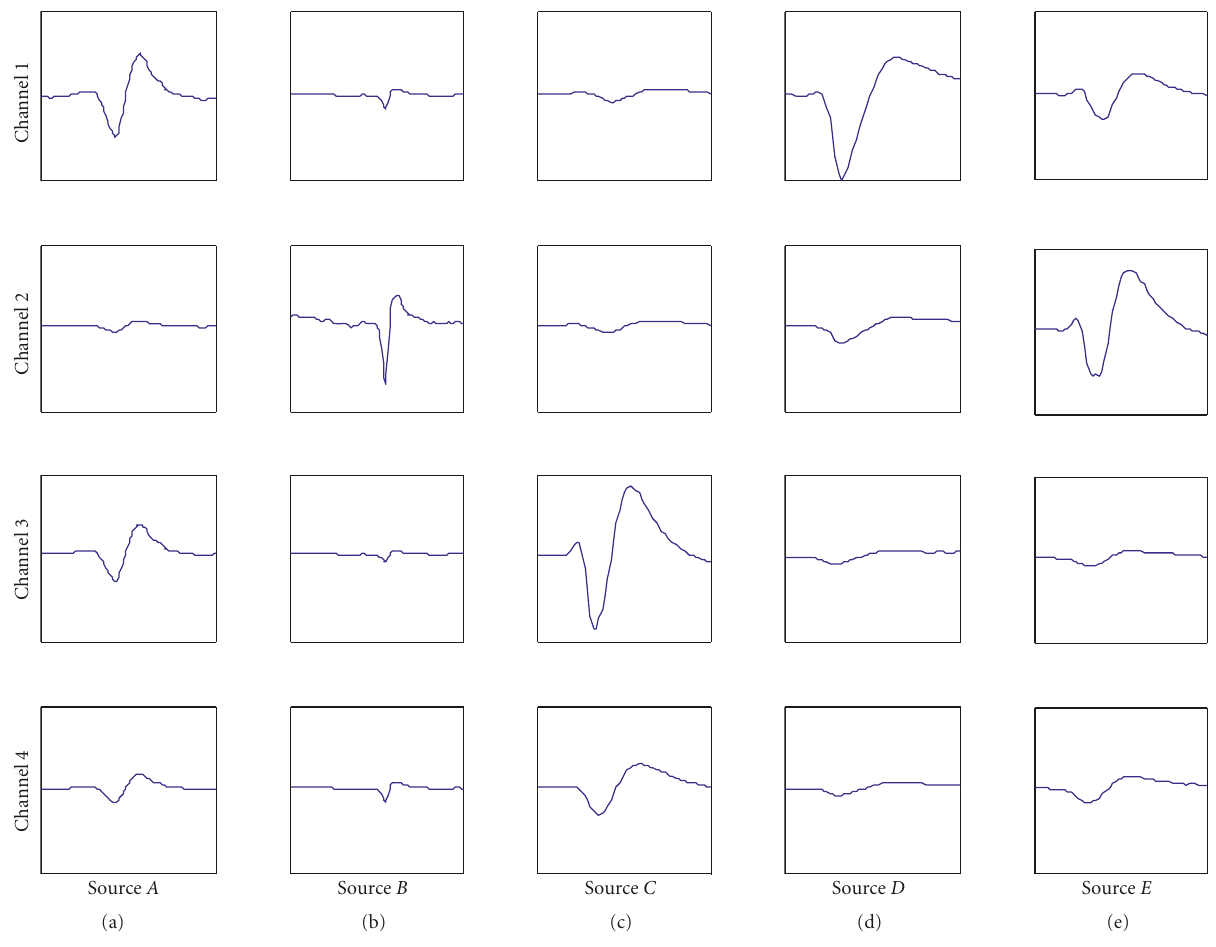
Figure 11: Template waveforms for 5 neural sources extracted from experimental data used to assess the consistency of the estimated